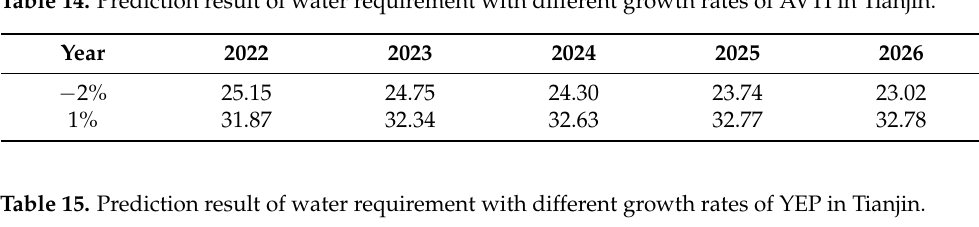
Table 14. Prediction result of water requirement with different growth rates of AVTI in Tianjin.